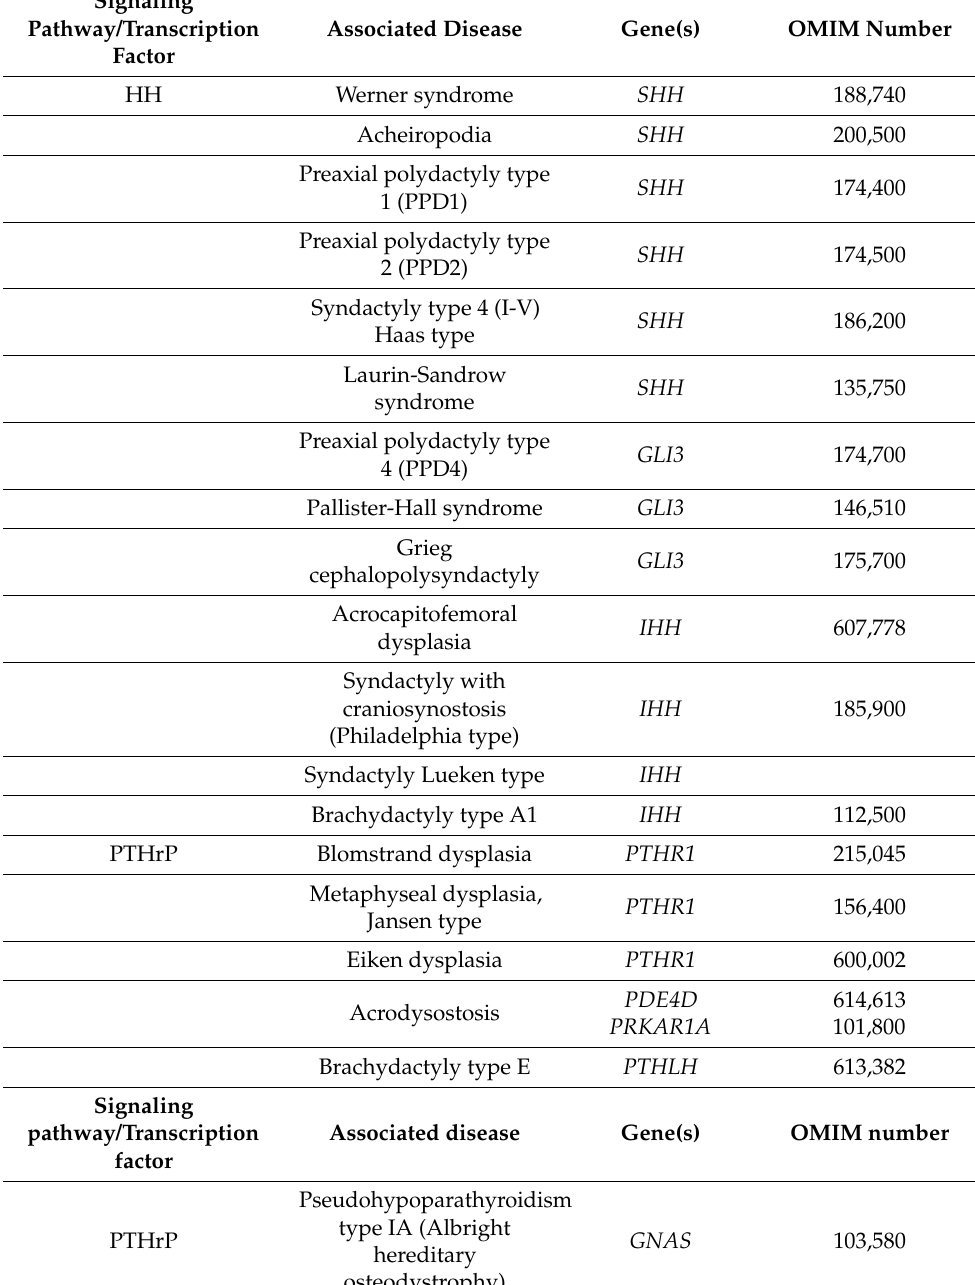
Table 1. Signaling pathways involved in bone development and associated skeletal